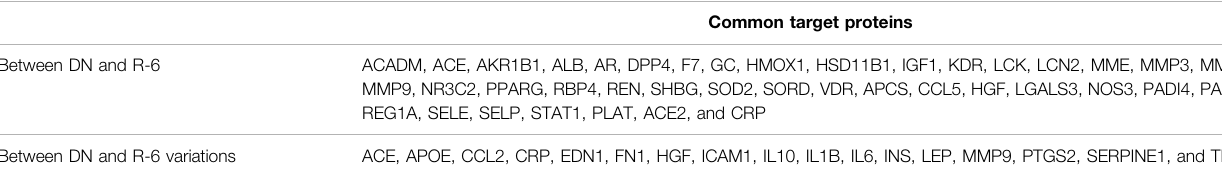
Common target proteins